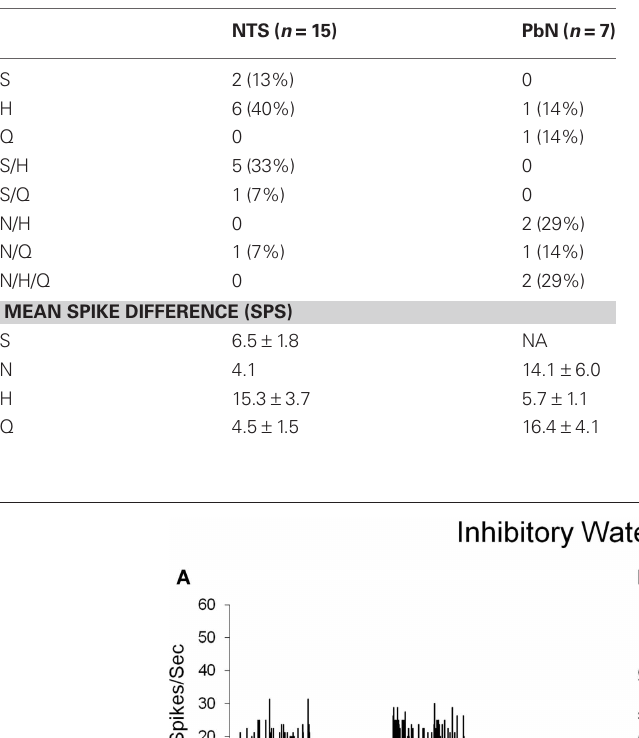
Table 3 | incidence of conditional response following each taste stimulus.